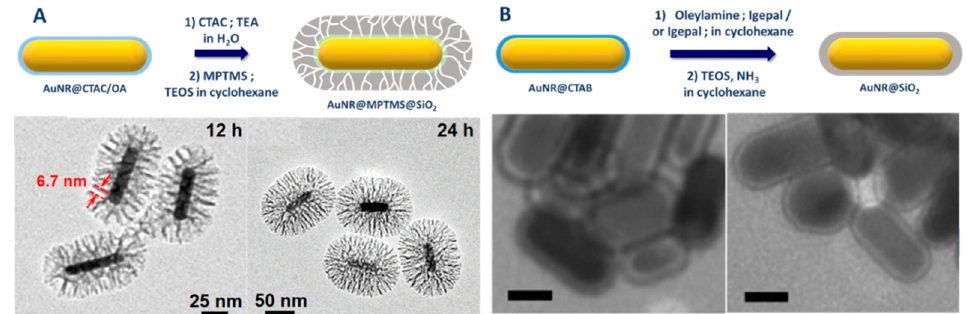
Figure 10. ( A ) AuNR@SiO 2 with a highly porous silica shell grown in a biphasic solution [92]. ( B ) Silica coating of gold nanorods by reverse microemulsion from ref [77].